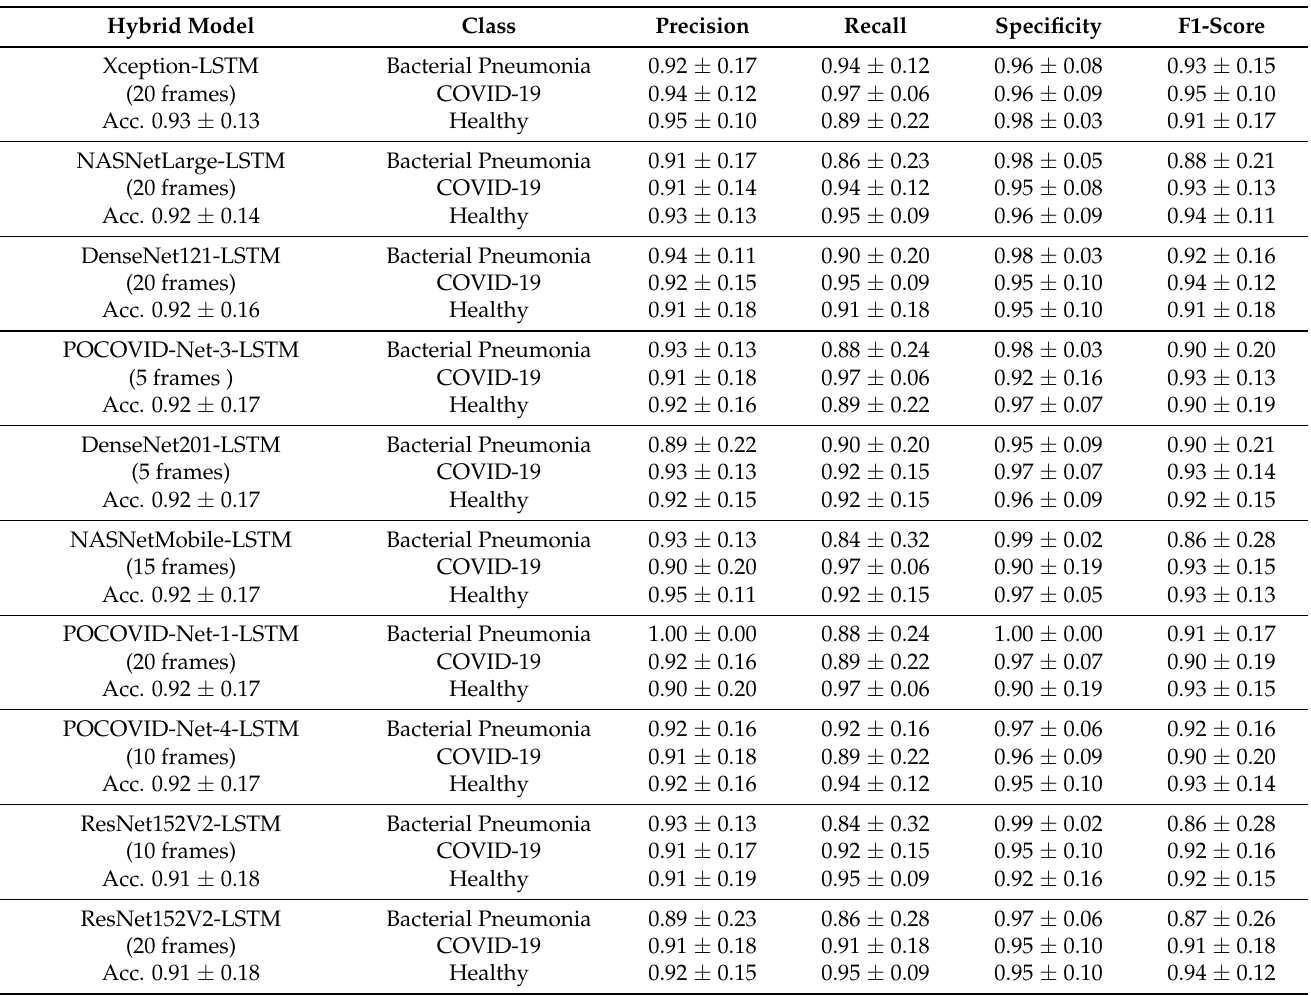
Table 8. Summary of the top 10 models ordered by average accuracy and F1-Score for COVID-19.